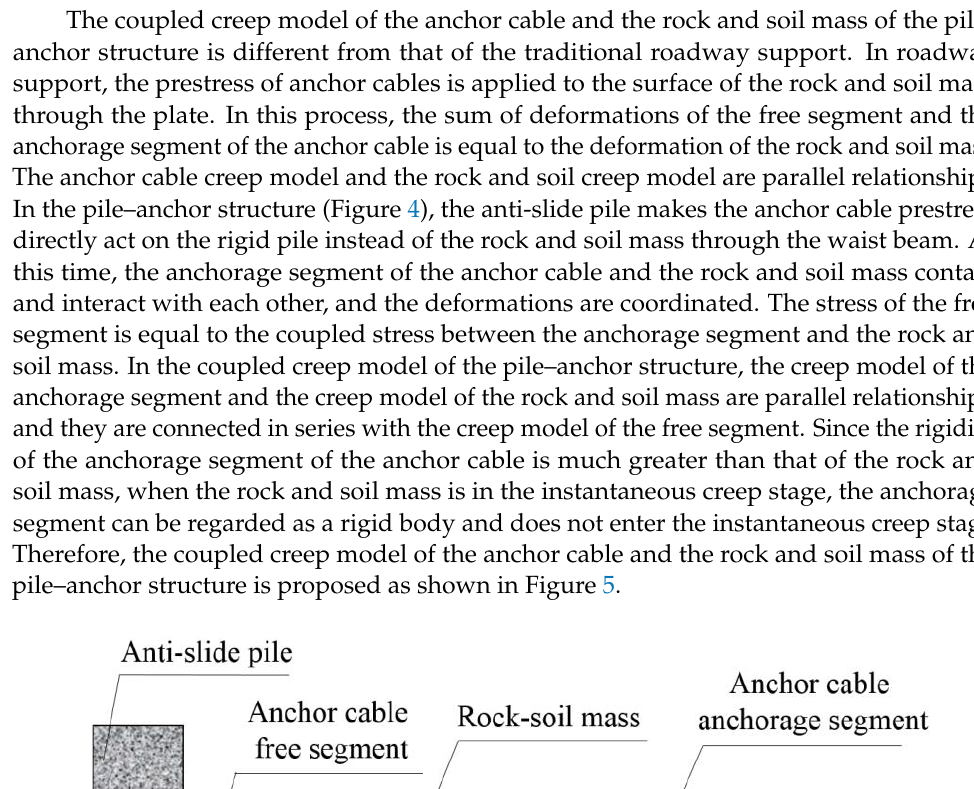
Figure 5. The anchor cable – rock and soil coupled creep model. According to the coupled creep model of the anchor cable and the rock and soil mass of the pile – anchor structure, the constitutive equation is deduced as: ++=++ AB